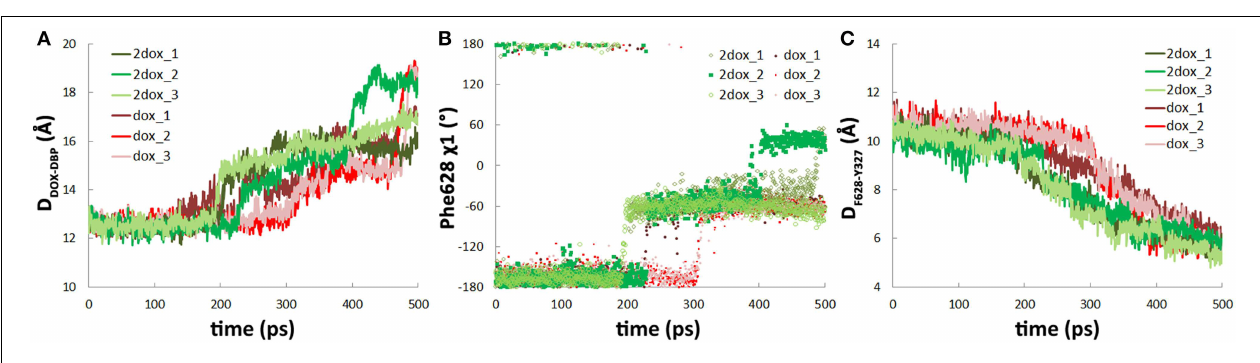
FIGURE 4 | The second substrate binding at monomer A accelerates the dissociation of doxorubicin from the DBP in monomer B. (A) Comparison of the variations of the distance between doxorubicin and the DBP of monomer B in dox and 2dox systems. (B)